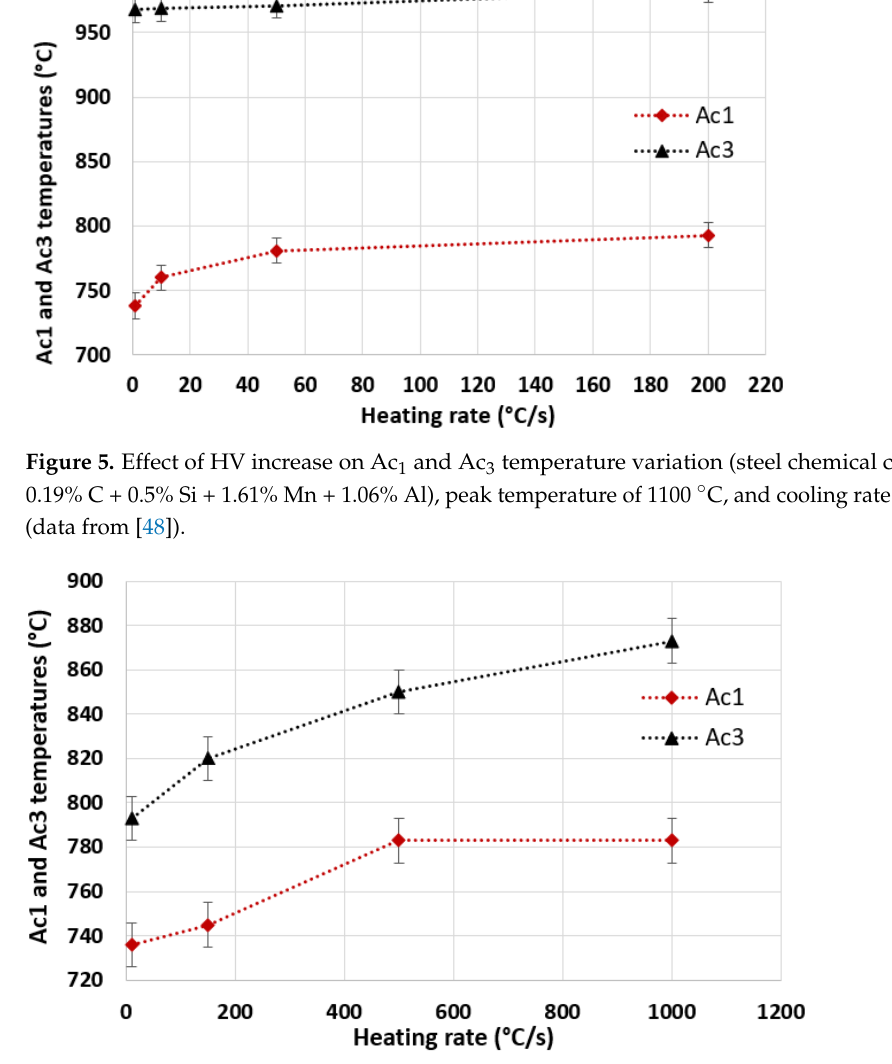
Figure 6. Ac 1 and Ac 3 temperature variation with an increase in HR (steel chemical composition 0.25%C + 1.5%Si + 3.0%Mn) (data from [40]).